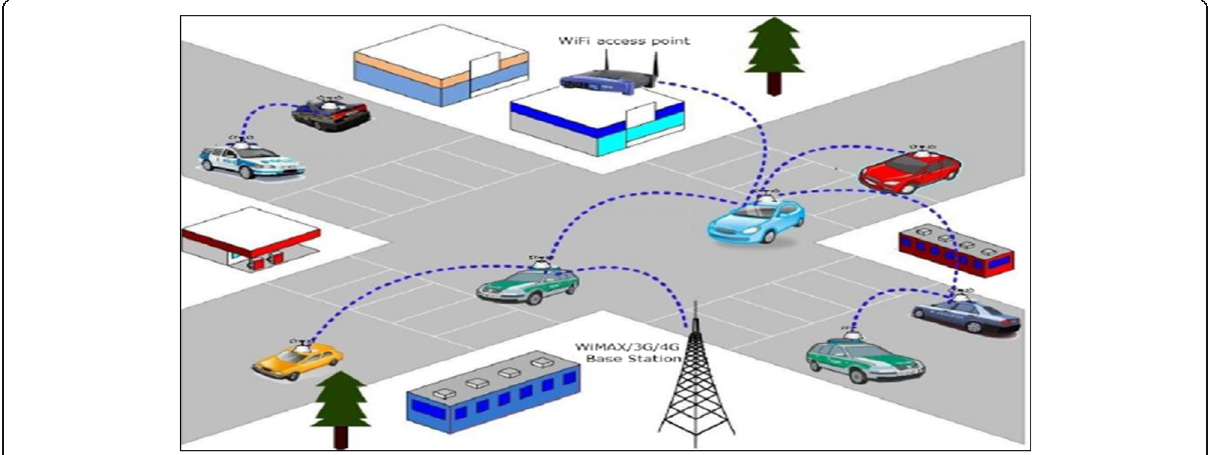
Fig. 1 Vehicular ad hoc network. A special category of MANETs is the vehicular ad hoc network (VANET). In VANETs, communications occur between adjacent vehicles and between vehicles and fixed units placed at special locations such as intersections and parking